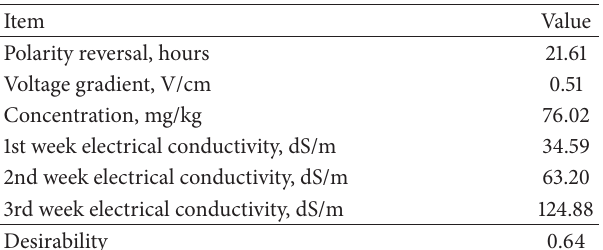
Table 3: Results of numerical optimization of factors and responses using